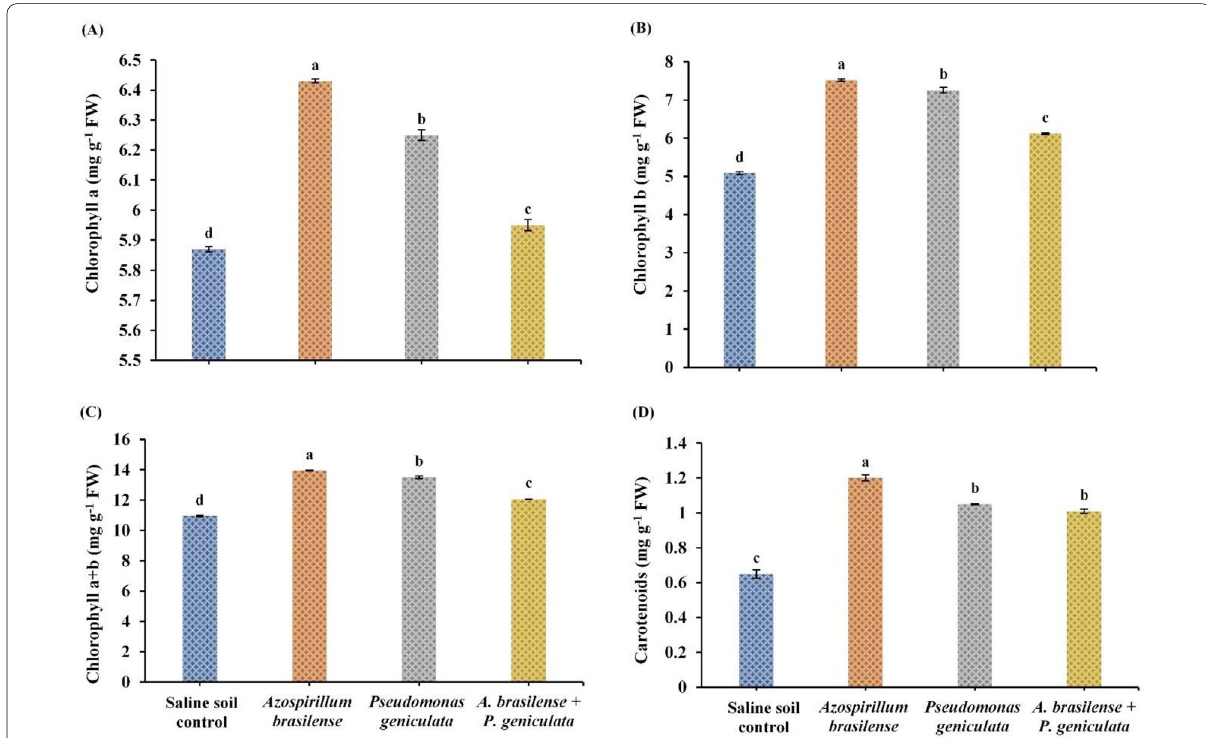
Fig. 2 Effect of the inoculation with Azospirillum brasilense , Pseudomonas geniculata individually or co-inoculation on Photosynthetic pigments (mg g − 1 FW) ( A ) Chlorophyll a; ( B ) Chlorophyll b; ( C ) Chlorophyll a b and ( D ) Carotenoids of flax plants ( Linum usitatissimum ) grown in saline soil. Bars + represent the mean of three replicates (n 3), vertical bars indicate standard error. Different letters indicate significant difference among means = ± according to LSD test at p < 0.05. FW fresh